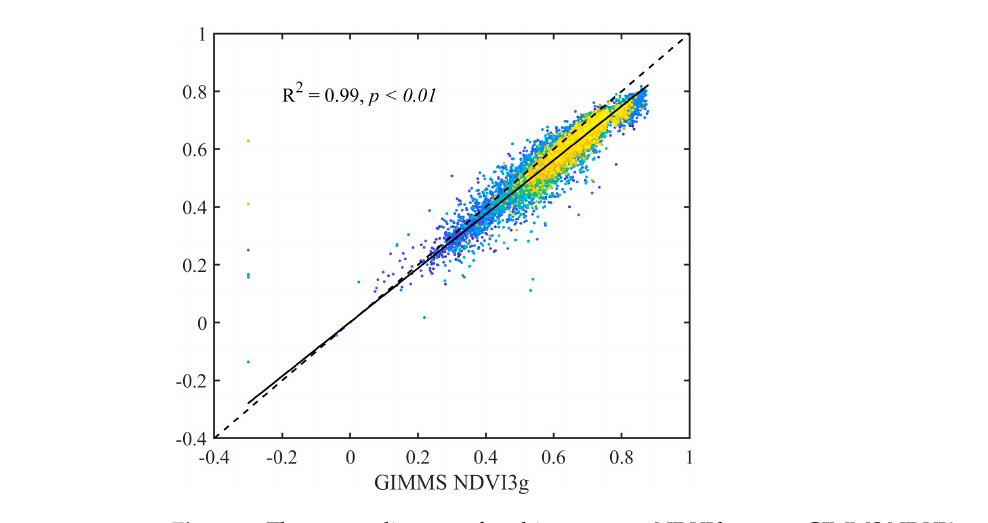
Figure 2. The scatter diagram of multi-year mean NDVI between GIMMS NDVI3g and MODIS NDVI in pixel level.